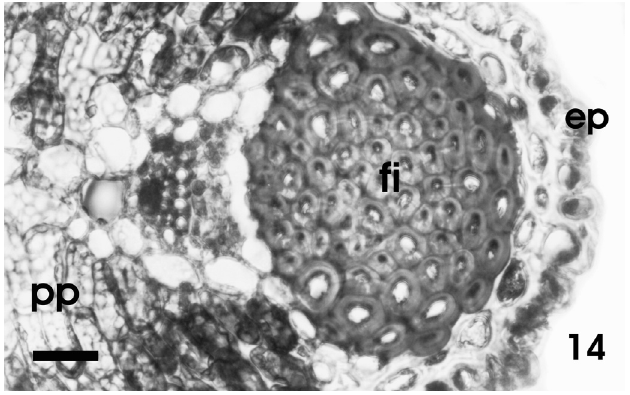
FIGURA 14 – B. trimera – Borda da ala do cladódio, em secção transversal. ep: epiderme; fi: fibras esclerenquimáticas; pp: parênquima palicádico. Barra = 20 µ m.